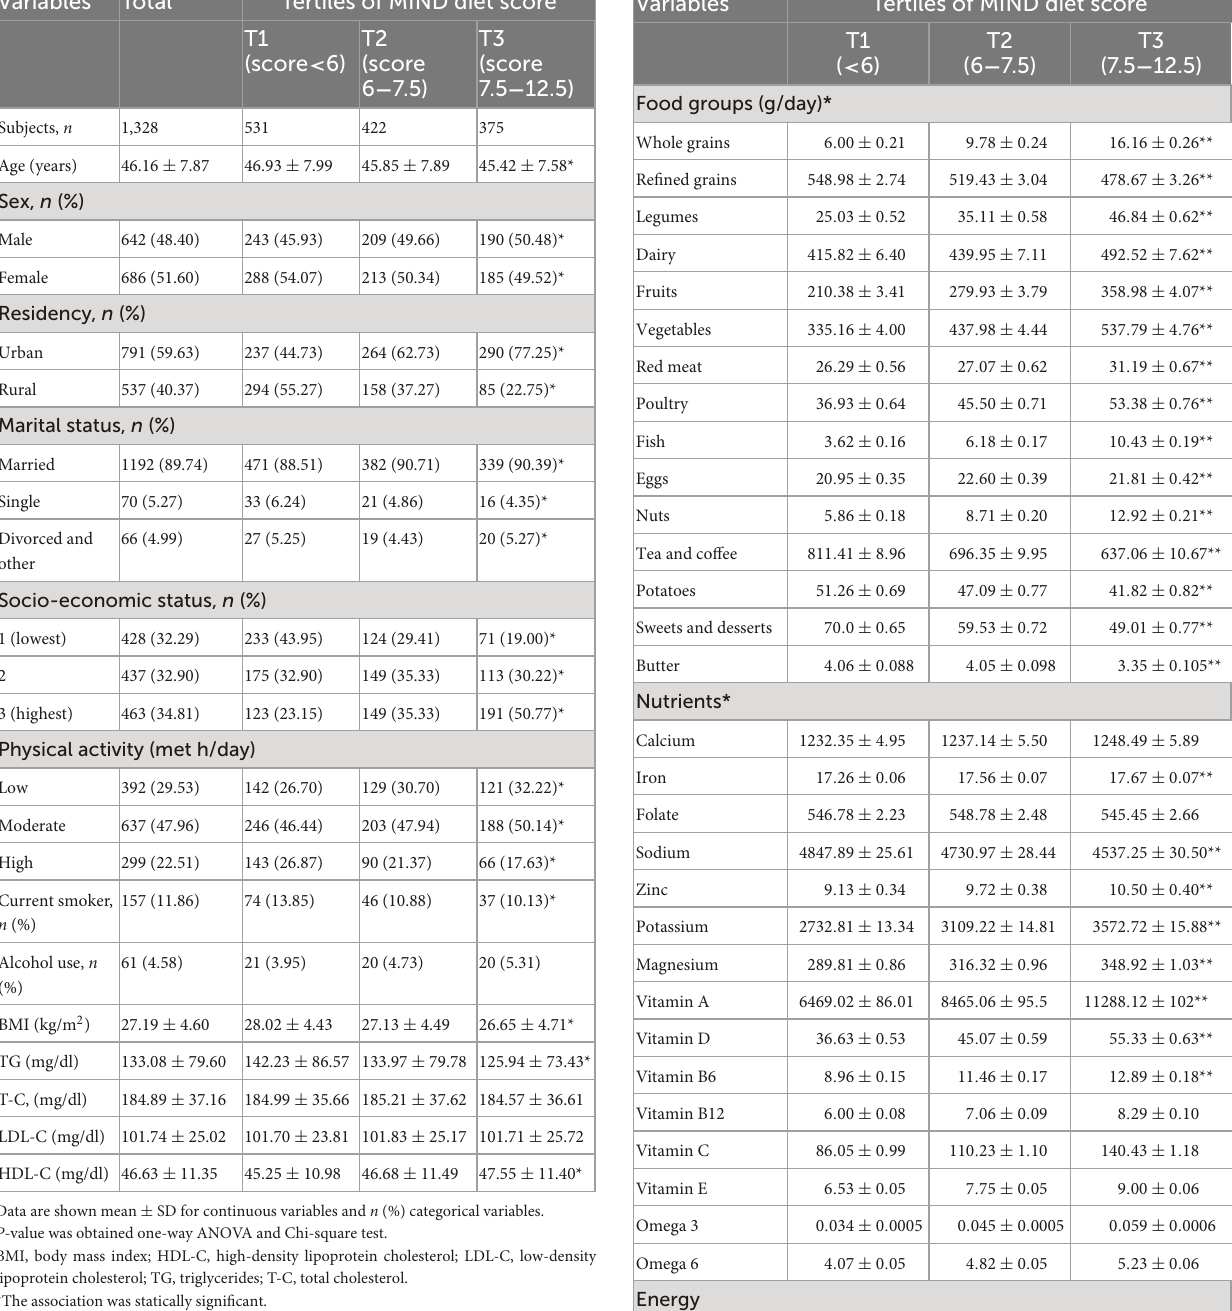
TABLE 3 Dietary intake of macronutrients and components of MIND diet score according to the tertiles (T) of the MIND diet score. Variables Tertiles of MIND diet